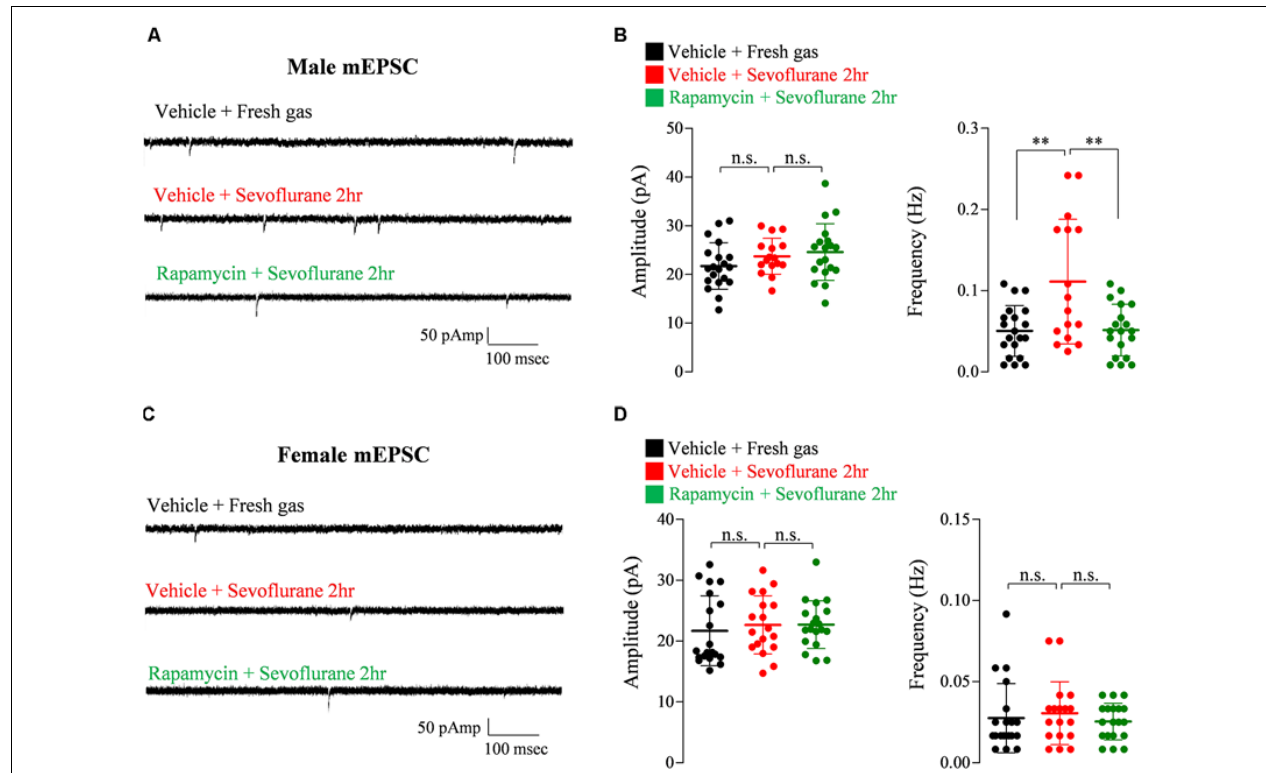
FIGURE 4 | Rapamycin prevents the increase in excitatory synaptic transmission in PND 16/17 male mice 24 h after sevoflurane exposure. (A,B) Frequency and amplitude of miniature excitatory postsynaptic currents (mEPSCs) in male mice 24 h after sevoflurane exposure with/without rapamycin pretreatment (control: 20 cells from three mice; sevoflurane: 16 cells from three mice; rapamycin: 19 cells from three mice; n.s., not significant, ∗∗ p < 0.01). (C,D) Frequency and amplitude of mEPSC in female mice 24 h after sevoflurane exposure with/without rapamycin pretreatment (control: 20 cells from three mice; sevoflurane: 18 cells from three mice; rapamycin: 19 cells from three mice; n.s., not significant). Values are presented as mean ±